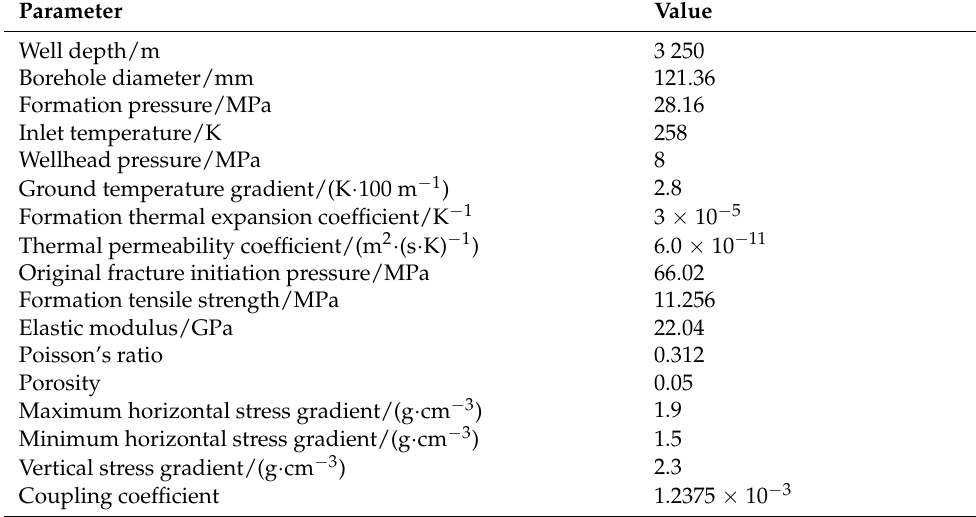
Table 1. Basic parameters.